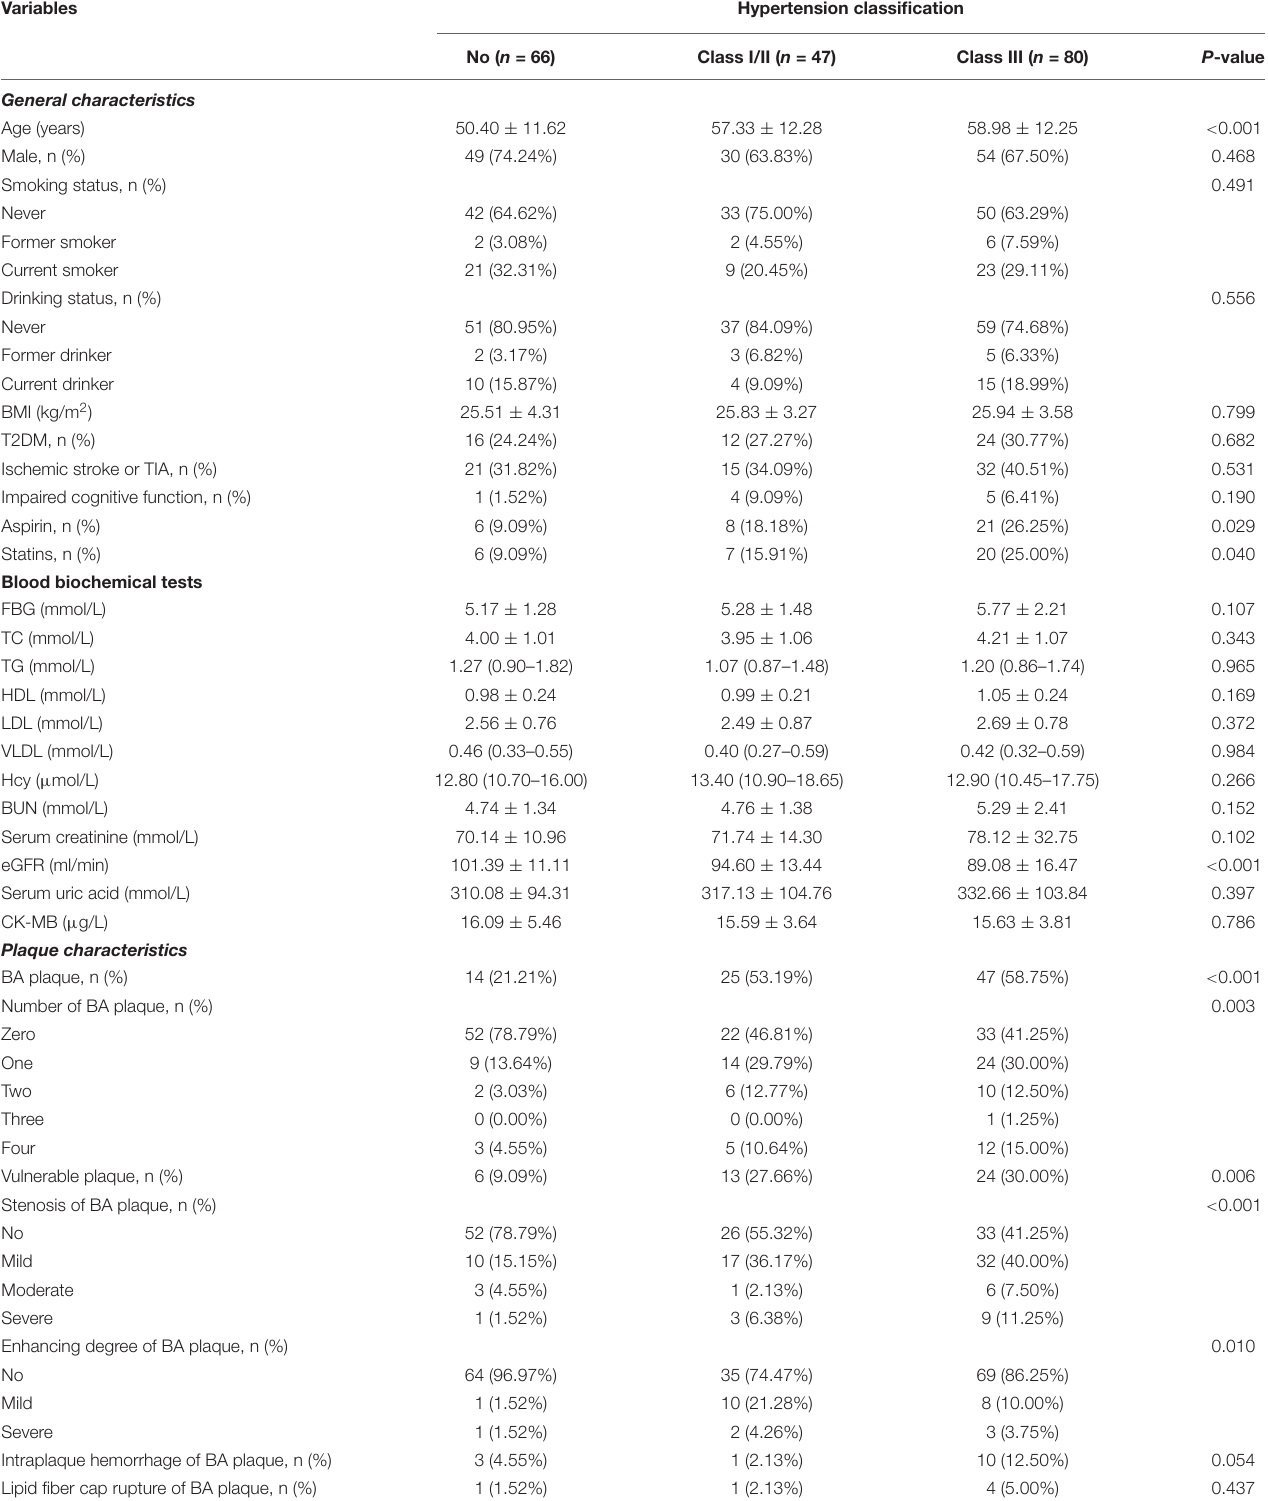
TABLE 2 | Clinical characteristics of the participants grouped by the hypertension